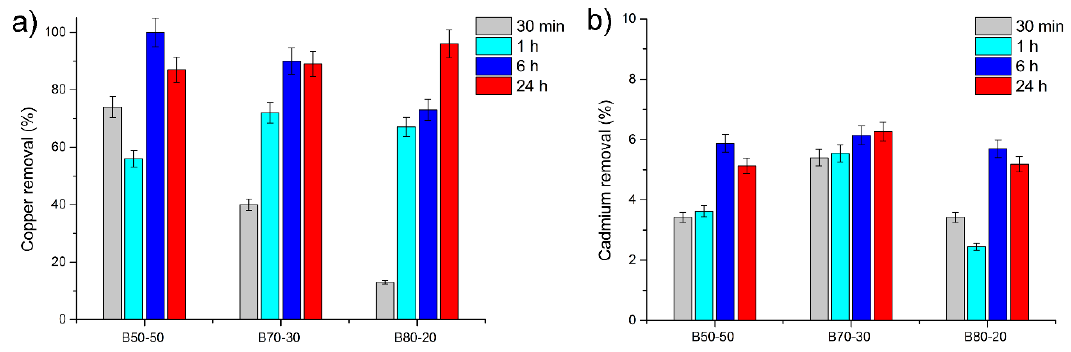
Figure 7. SEM micrographs of cured fibers and histograms showing the fiber diameter distribution: Poly- β CD ( a ), B50_50 ( b ), B70_30 ( c ), B80_20 ( d ), B80_20 after adsorption and desorption of copper ( e ) and cadmium ( f ).